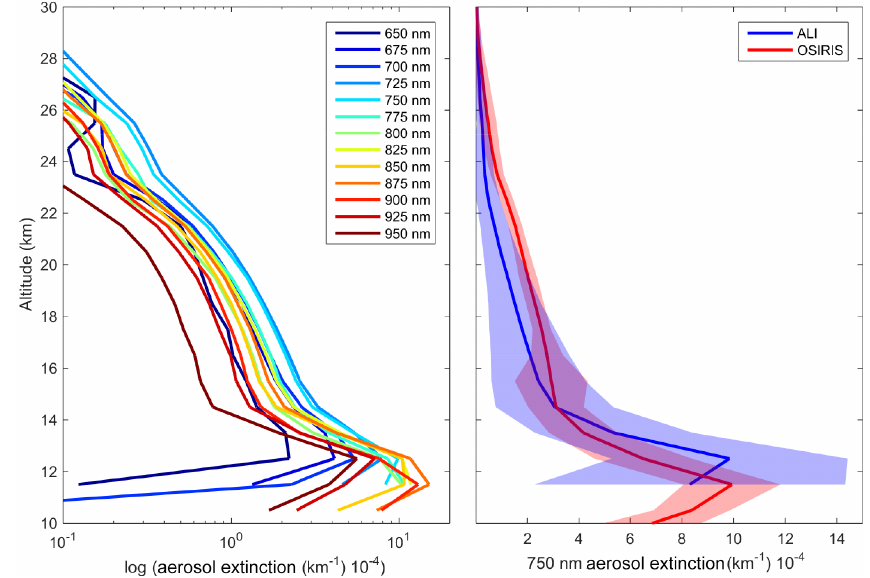
Figure 12. Left is the retrieved aerosol extinction profiles from the last complete imaging cycle consisting of images 205 to 216 from the 0.0 ◦ horizontal line of sight. Right is the 750nm ALI aerosol extinction in blue compared to the 750nm extinction measured by OSIRIS in red with its error represented by the respective